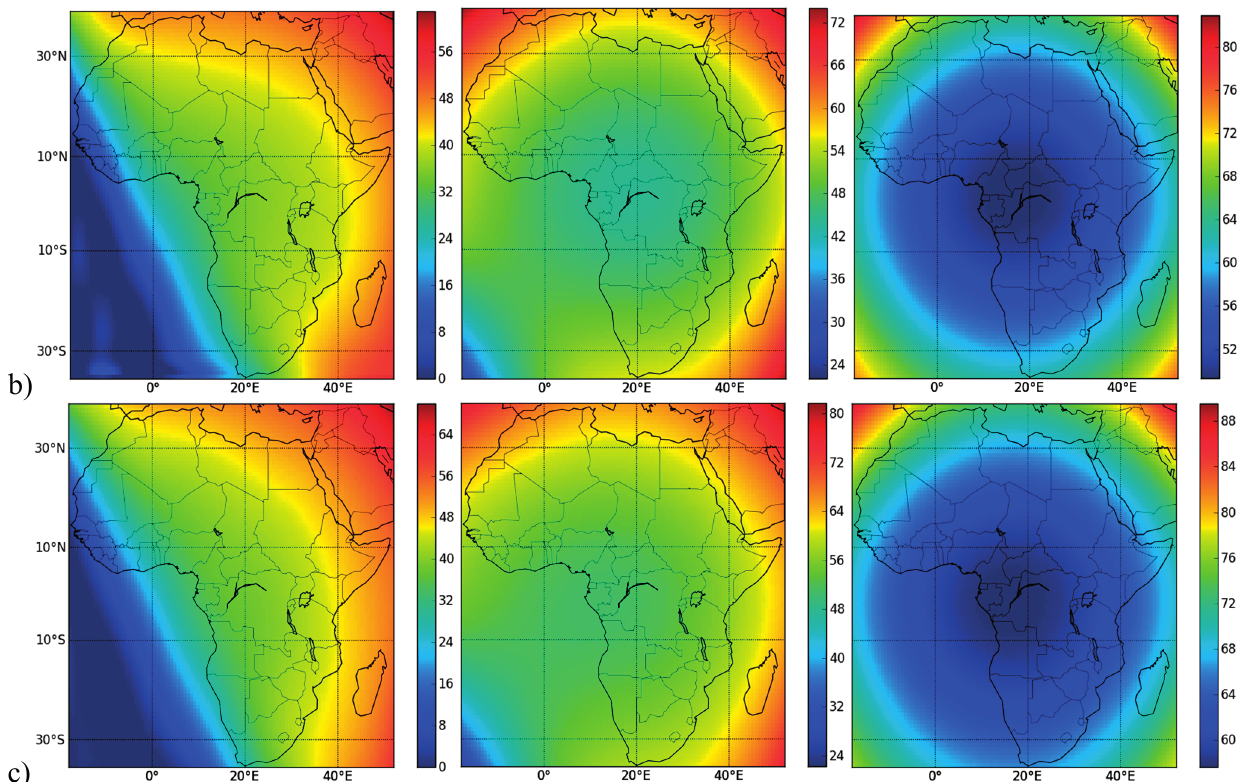
Figure 9. DART simulated BOA ( a ), atmosphere ( b ) and TOA ( c ) radiance (W/m 2 /sr/µm) at 443 nm, for 6 h 44 m ( left ), 8 h 44 m ( middle ) and 10 h 44 m ( right ) UTC as measured by a geostationary satellite at Latitude 0° N, Longitude 17° E and 36,000 km altitude on 21 June 2012.